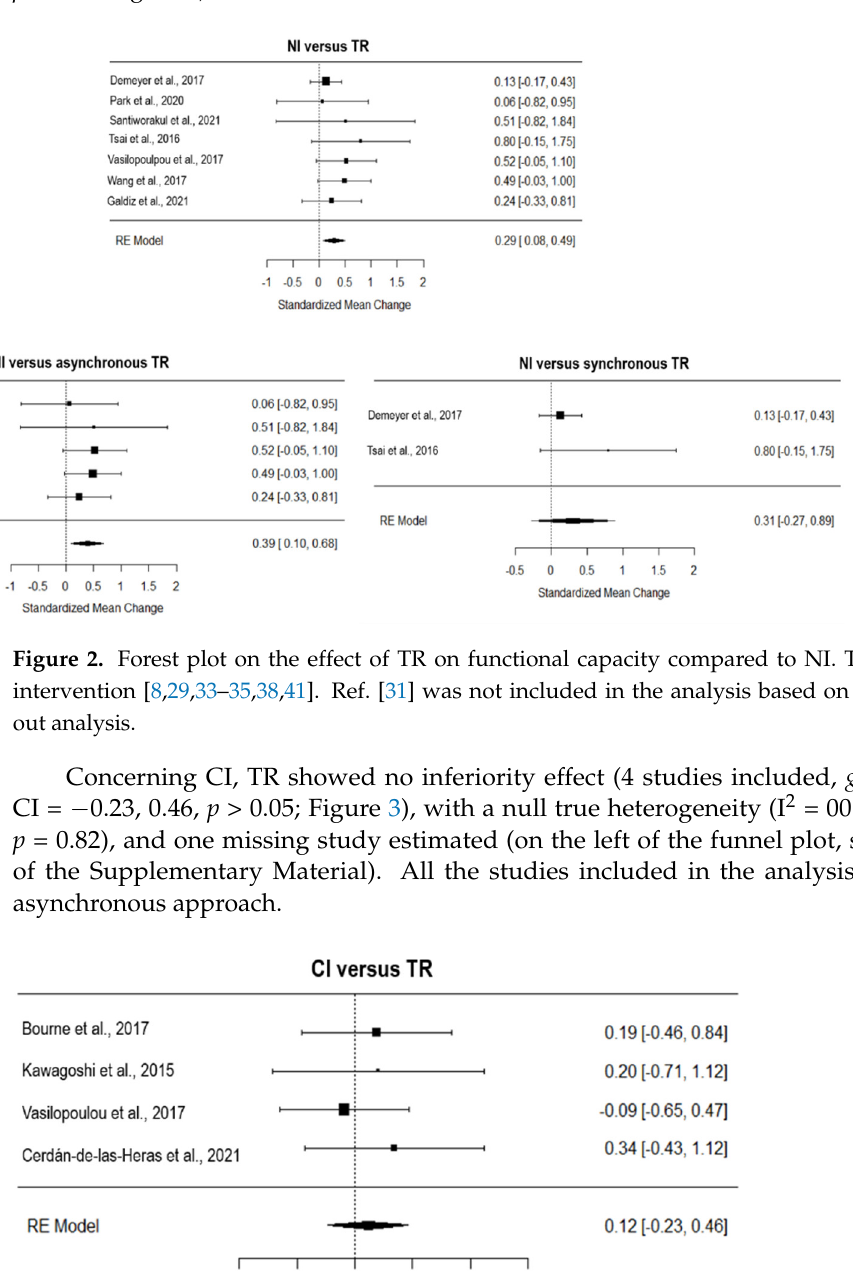
Figure 3. Forest plot of the effect of TR on functional capacity compared to conventional intervention. CI, conventional intervention; TR, TR intervention [8,24,26,37].